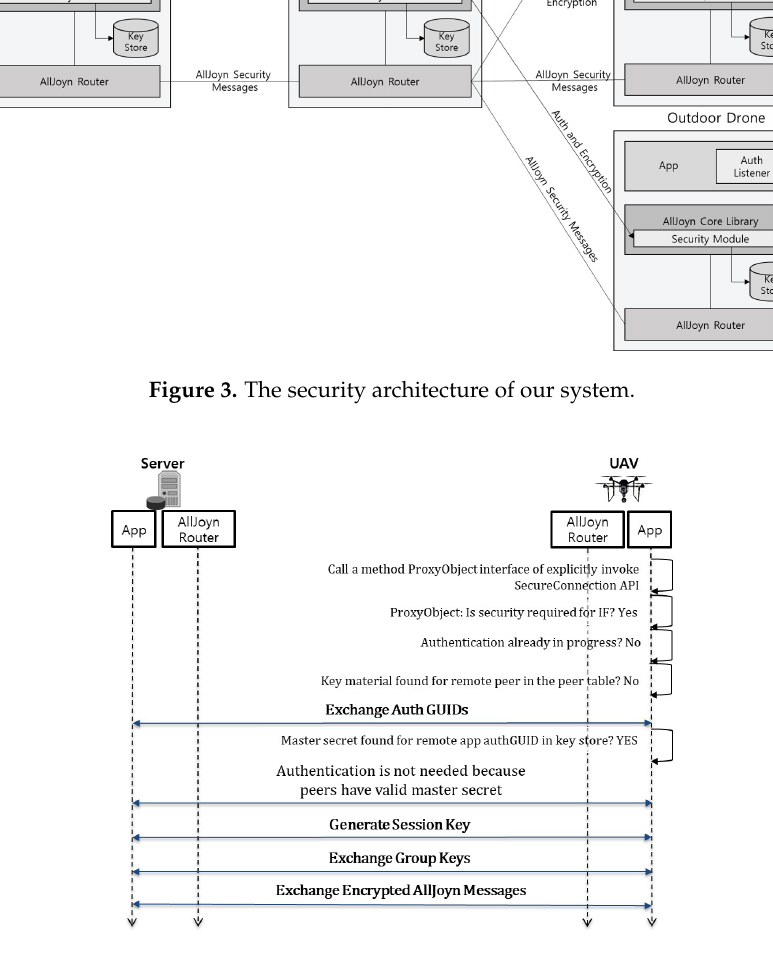
Figure 4. The end to end security flow of our UAV-EMOR